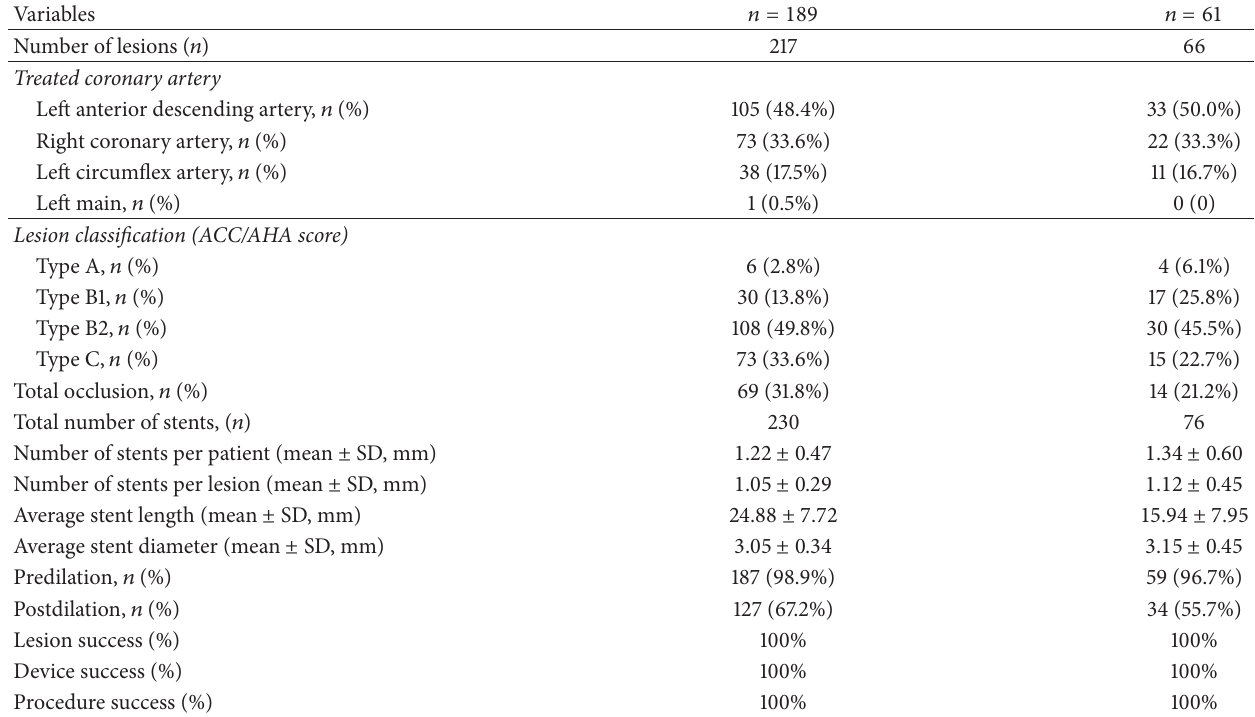
Table 2: Lesion and procedural characteristics for the entire population ( 𝑛 = 189 ) and for patients undergoing examination by quantitative coronary angiography ( 𝑛 = 61 ) at 9 months.